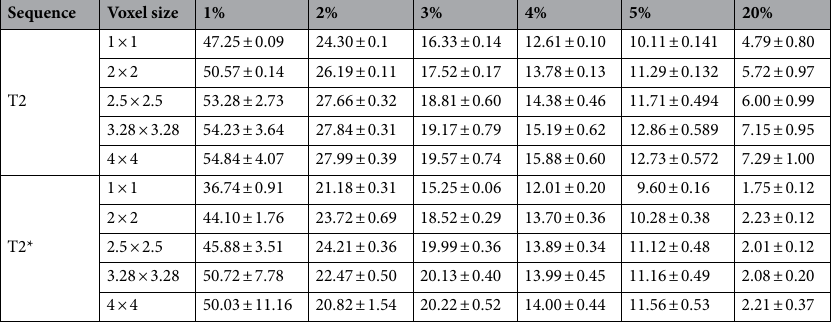
Table 2. Phantom mean measurements ± standard deviation for different pixel size using T2 and T2*.